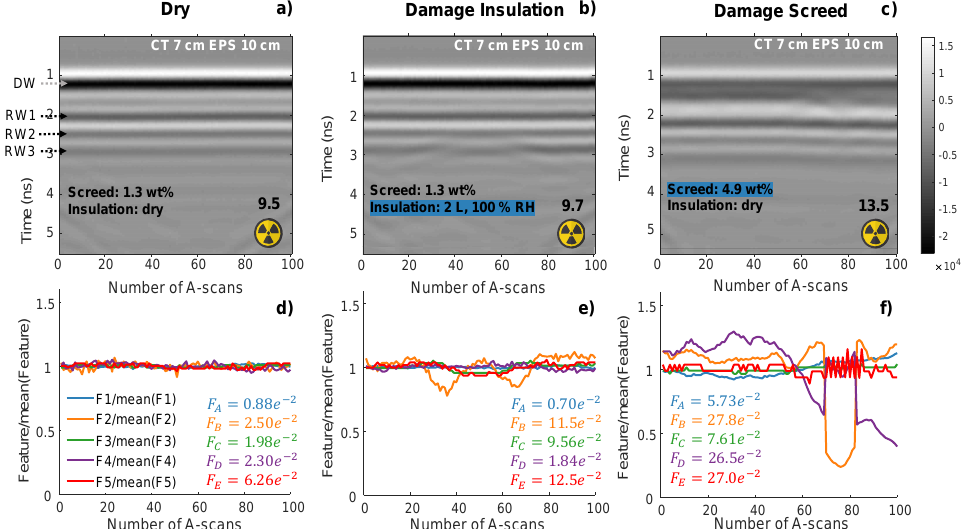
Figure 9. Measurements at a 7 cm CT and 10 cm EPS floor construction for the scenarios: ( a ) Dry, ( b ) damage insulation, and ( c ) damage screed. The bottom ( d – f ) shows the respective A-scan vector plots for each B-scan